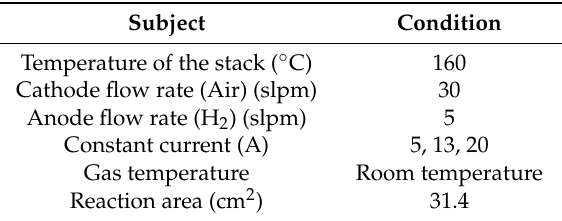
Table 1. Testing conditions for the HT-PEMFC stack.